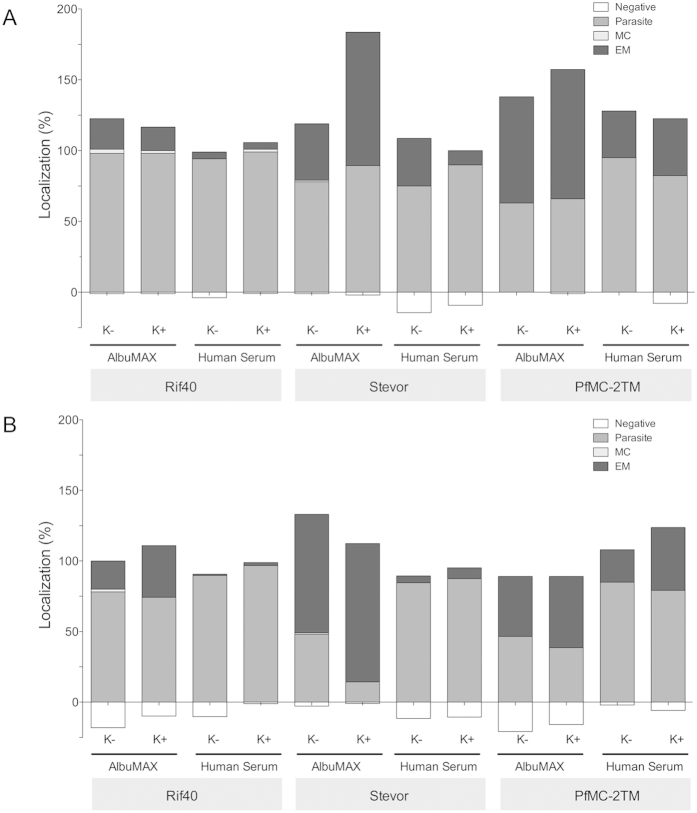
Localization of small VSA within infected erythrocytes.The localization of RIFIN, STEVOR, and PfMC-2TM proteins was quantified in trophozoite-stage parasites (28-32 hpi). Shown are percentages of proteins inside the parasitic boundaries (parasite, dark grey), associated within the Maurer’s clefts (MC, light grey), and at the erythrocyte membrane (E, black) as well as without specific fluorescence signal (negative, white). One hundred IEs were counted for each staining; however, the overall percentage is greater than 100 because some proteins localized to multiple sites within a single cell. A. Immunofluorescence microscopy of 3D7 IEs. B. Immunofluorescence microscopy of FCR3 IEs. K-, cultivation in the presence of AlbuMAX or human serum; K+, cultivation in the presence of AlbuMAX or human serum plus gelatin sedimentation to enrich knobby IEs. HS, human serum.